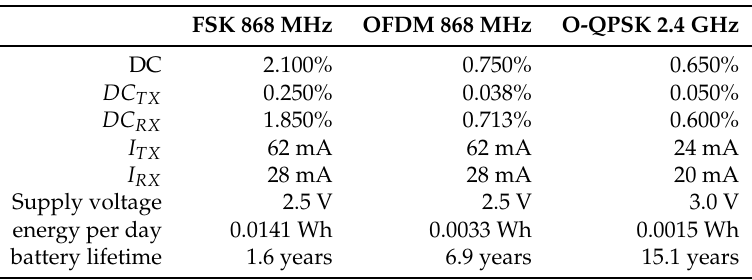
Figure 9. Evolution of the mote’s radio duty cycle over time. Table 4. “Ideal battery” lifetime for each configuration.